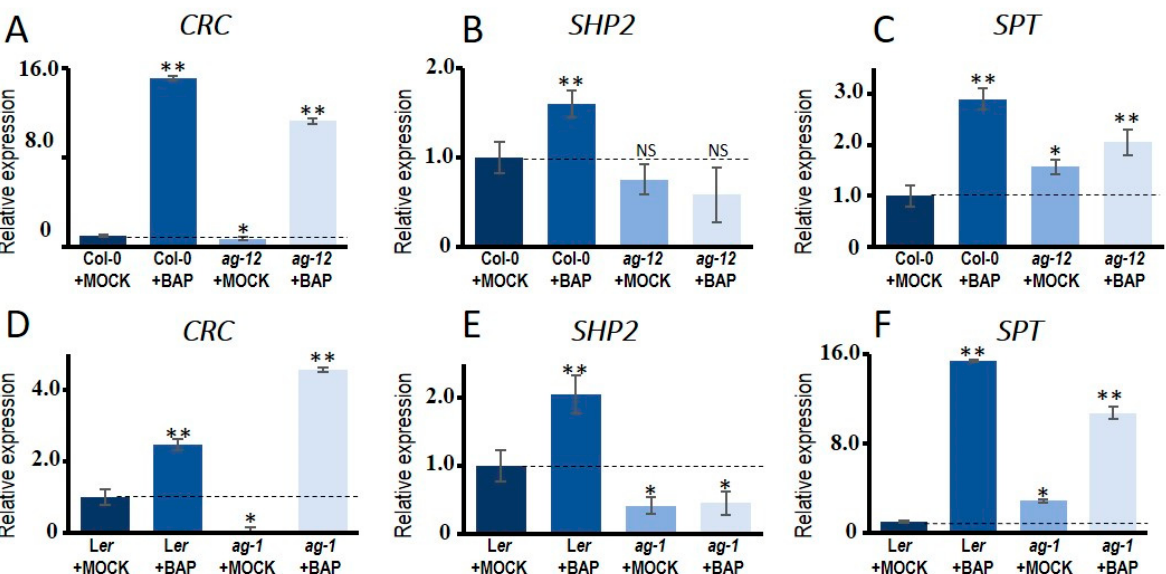
Figure 2. Expression levels of CRC, SPT and SHP2 in ag mutant backgrounds and wild type. ( A – F ) qRT-PCR expression data for CRC , SPT and SHP2 in floral buds after 24 h of cytokinin-treatment (100 µM BAP) or mock-treatment in the ag-12 mutant ( A – C ) and in the ag-1 mutant ( D – F ). The results were obtained for three independent biological replicates with three technical replicates for each one. One-way ANOVA was used to evaluate the significant differences. Significant values are indicated as follow: (*) p < 0.05, (**) p < 0.01, not significant (NS), compared to mock-treated wild type.